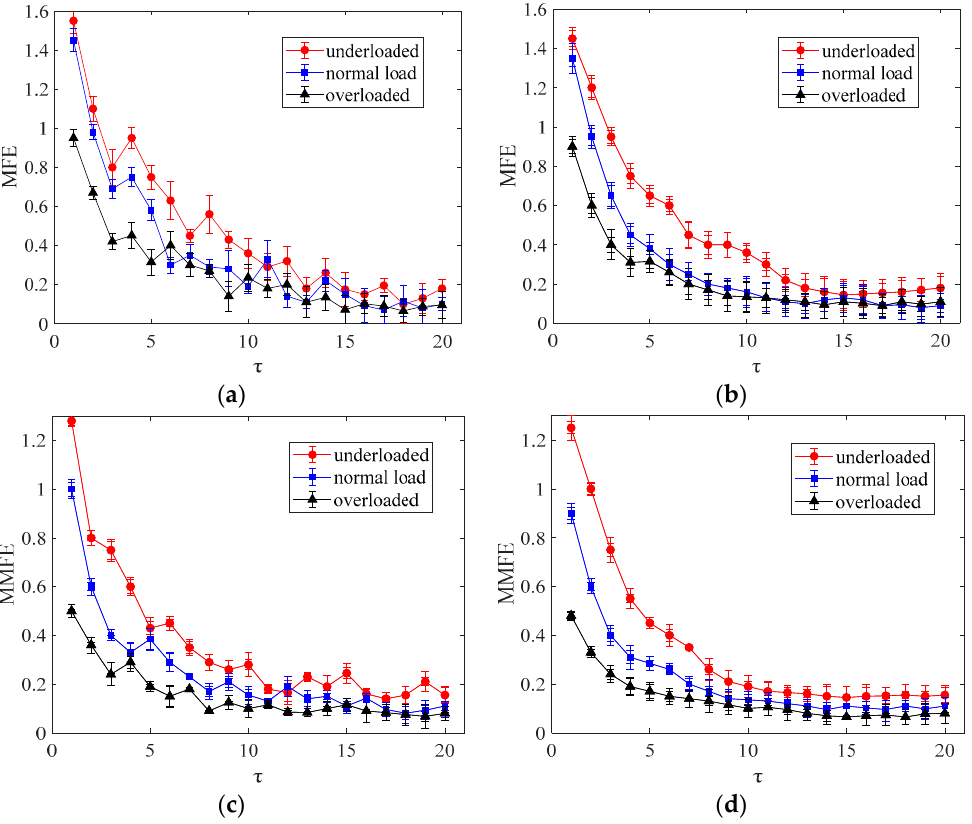
Figure 11. Reconstructed signal waveform under three working conditions: ( a ) EWT-MSE, ( b ) improved EWT-MSE, ( c ) EWT-MFE, and ( d ) improved